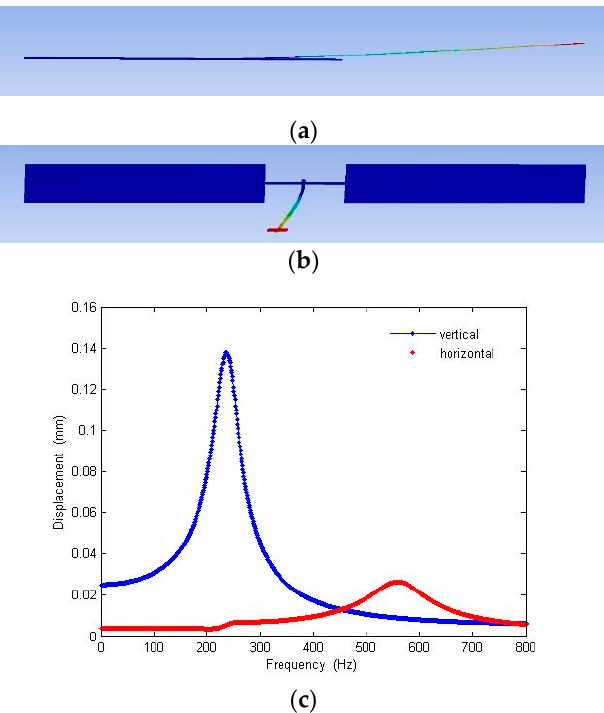
Figure 25. ANSYS modal analysis of scanner with slab width reduce to 10 microns. The two lowest frequencies 238.32 Hz and 562.68 Hz in the simulation appear closely matching the experiment results. ( a ) Mode shape at 238.32 Hz, ( b ) mode shape at 562.68 Hz. ( c ) Corresponding harmonic responses measured experimentally.